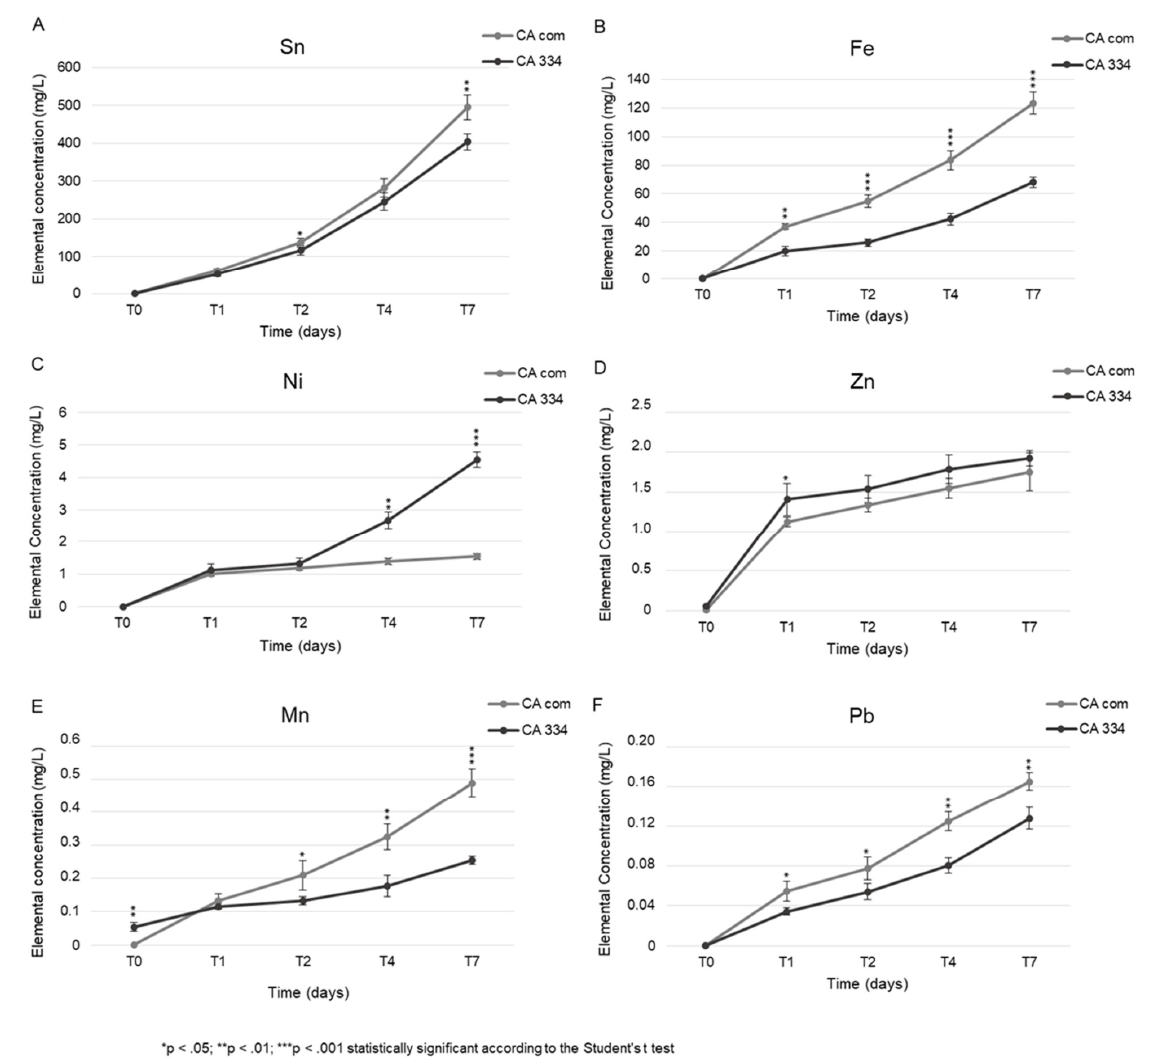
Figure 3. Trends of Sn ( A ), Fe ( B ), Ni ( C ), Zn ( D ), Mn ( E ), and Pb ( F ) amounts solubilized by the CA solution produced by Aspergillus niger NRRL 334 (CA 334) and by the commercial one (CA Com) over time, from T0 to 7 days (T7) of mouse circuit boards soaking. Data represent average concentrations from three independent measures ± uncertainty; * p < 0.05; ** p < 0.01; *** p < 0.001: statistically significant according to Student’s t -test.